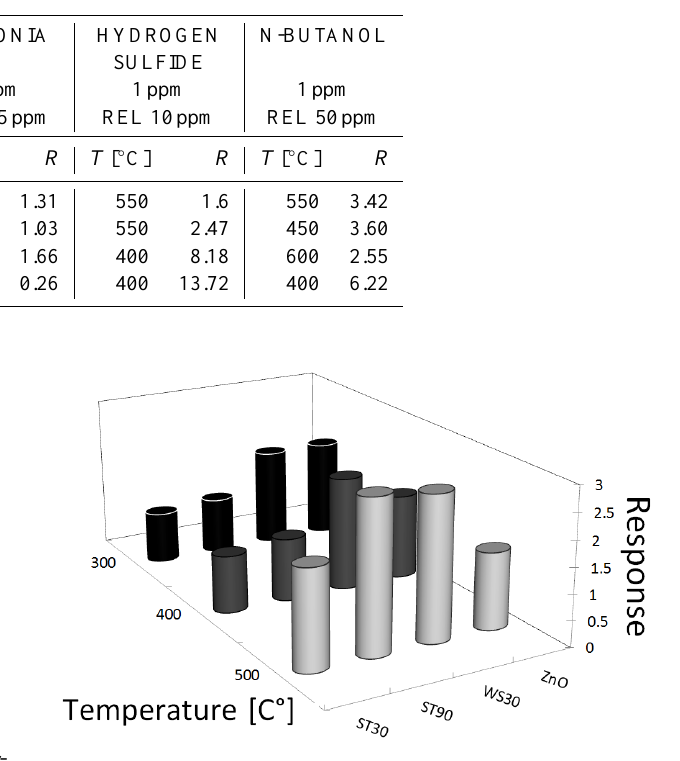
Figure 8. Responses of the sensors to 2ppm of C 6 H 6 at three dif- ferent temperatures.